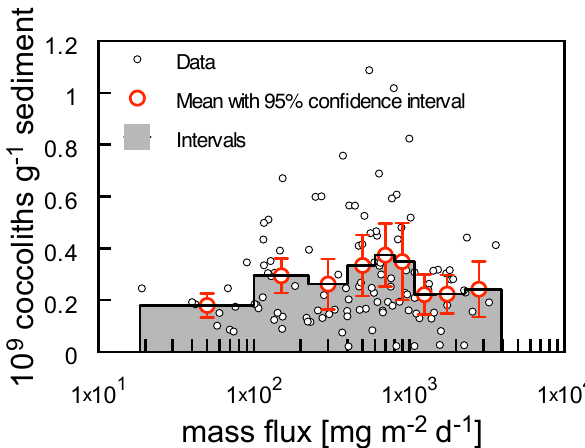
Figure 3. Emiliania huxleyi coccolith concentration in trap mate- rial versus total mass flux. Individual data points show an irregular scatter. Also the mean values within the mass flux intervals indi- cated by the grey bars show no increase with mass flux, indicating small influence of sediment transport and resuspension on coccolith